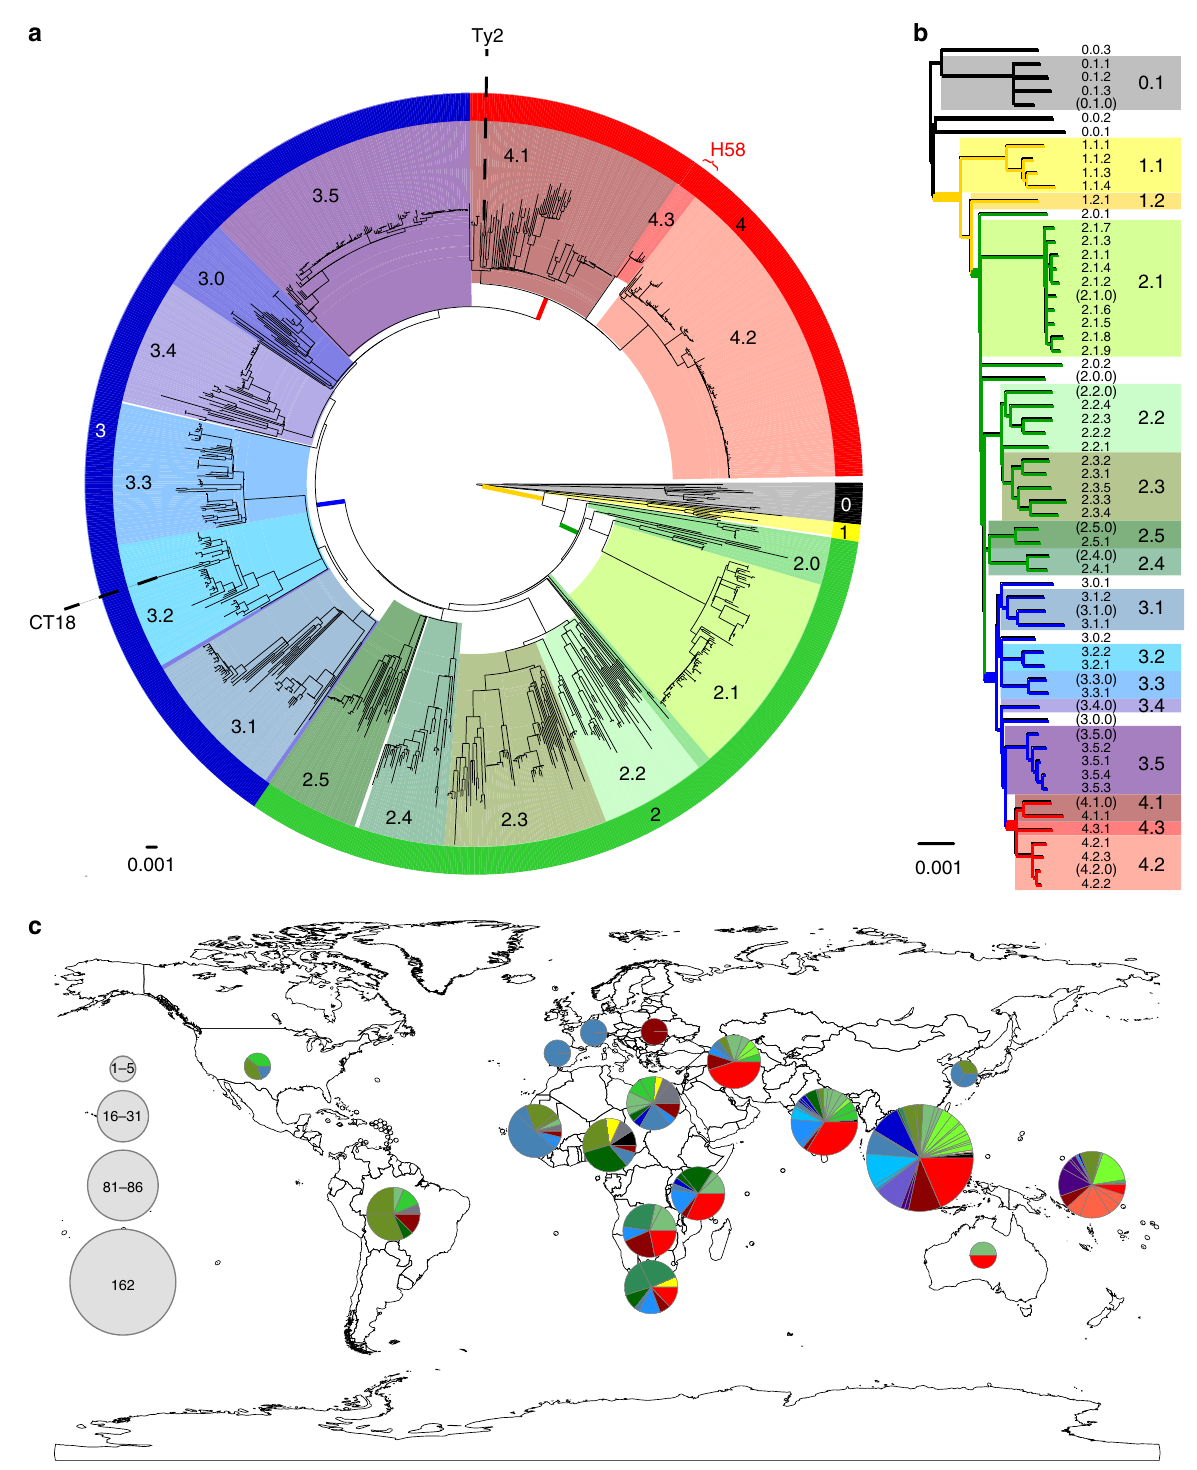
Figure 1 | Population structure of S . Typhi based on genome-wide SNPs. ( a ) Whole-genome tree of 1,831 global S . Typhi isolates. Primary clusters 1–4 are indicated in the outer coloured ring; branches defining these groups are coloured in the tree. These groups are further divided into clades, which are shaded and labelled. The location of S. Typhi reference genomes CT18 (accession number AL513382) and Ty2 (accession number AE014613) are indicated on the tree. Subclade 4.3.1 (H58, marked in red), which comprises half of the global collection, is represented by just 50 (6%) randomly selected isolates out of the total 852 belonging to this subclade, so that the relationships between other clades can be visualized. ( b ) Tree backbone showing further division of 16 S . Typhi clades (shaded) into 49 subclades (labelled; note 12 undifferentiated clade groups shown in brackets). Branches are coloured by primary cluster. ( c ) Map of the world showing subclade diversity of S . Typhi isolates in the global collection, by region 22 . Where groups of isolates from the same country and year belonged to the same subclade, this was classified as an ‘outbreak’ and the group is only represented once in the pie graphs. Pies are sized to indicate number of isolates; slices are coloured by clade; multiple slices of the same colour indicate multiple subclades belonging to the same